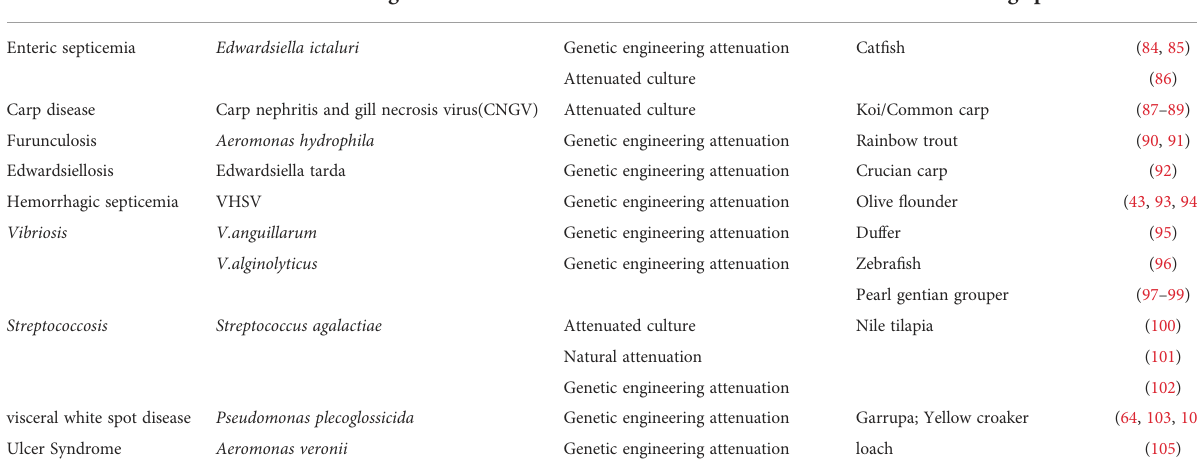
TABLE 3 Attenuated